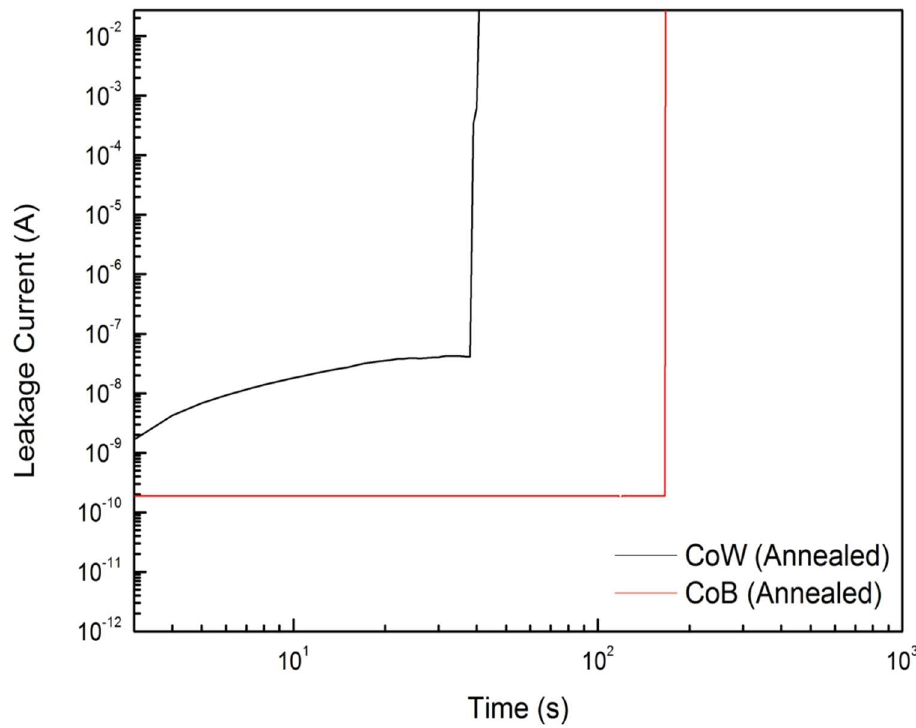
Figure 8. Leakage current versus stressing time for annealed CoW-gate and CoB-gate MIS capacitors during TDDB tests.